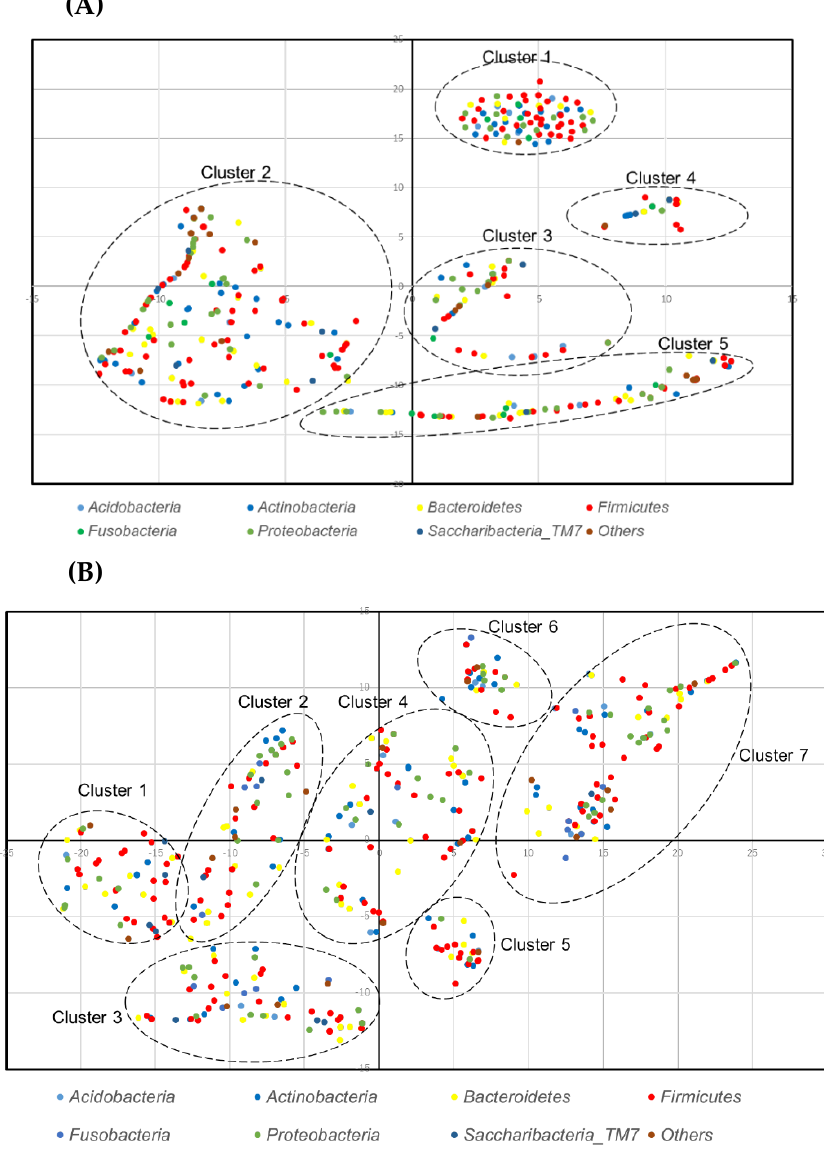
Figure 3. t-distributed stochastic neighbor embedding (tSNE) plot of species: ( A ) denture plaque, and ( B ) the tongue.